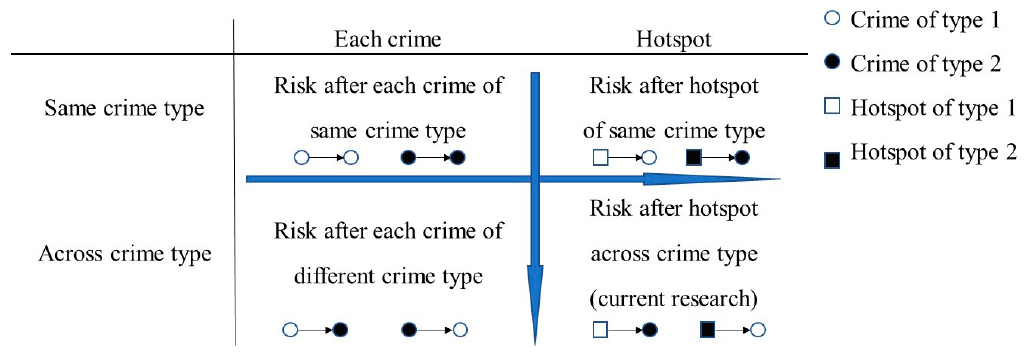
Figure 1. Demonstration of current research.